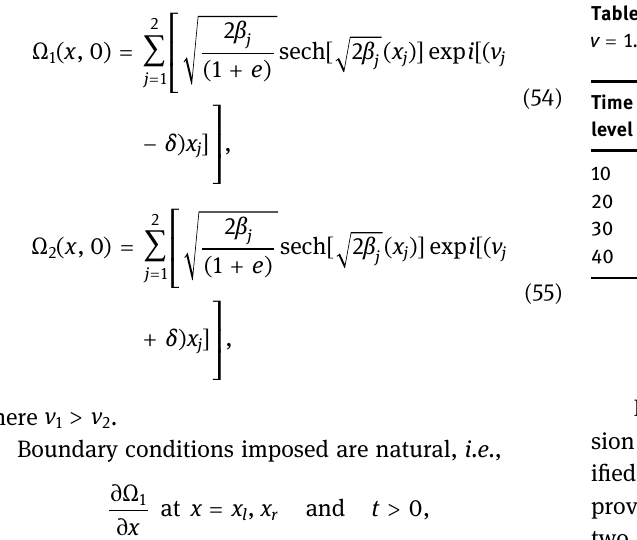
Figure 2: Solutions of second - wave amplitude for = x 0.001 , = β 1 , = e 2 30 and 40.